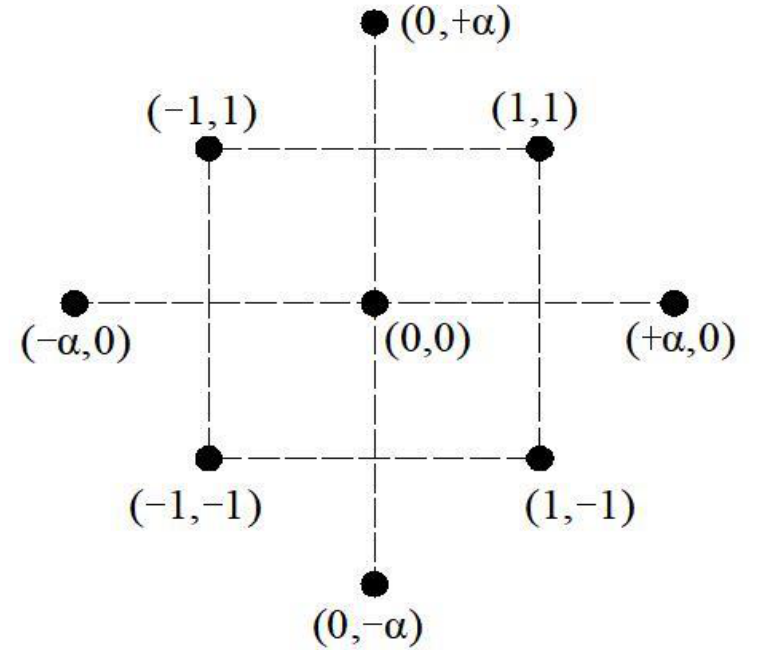
Figure 4. The horizontal point distribution of CCD.